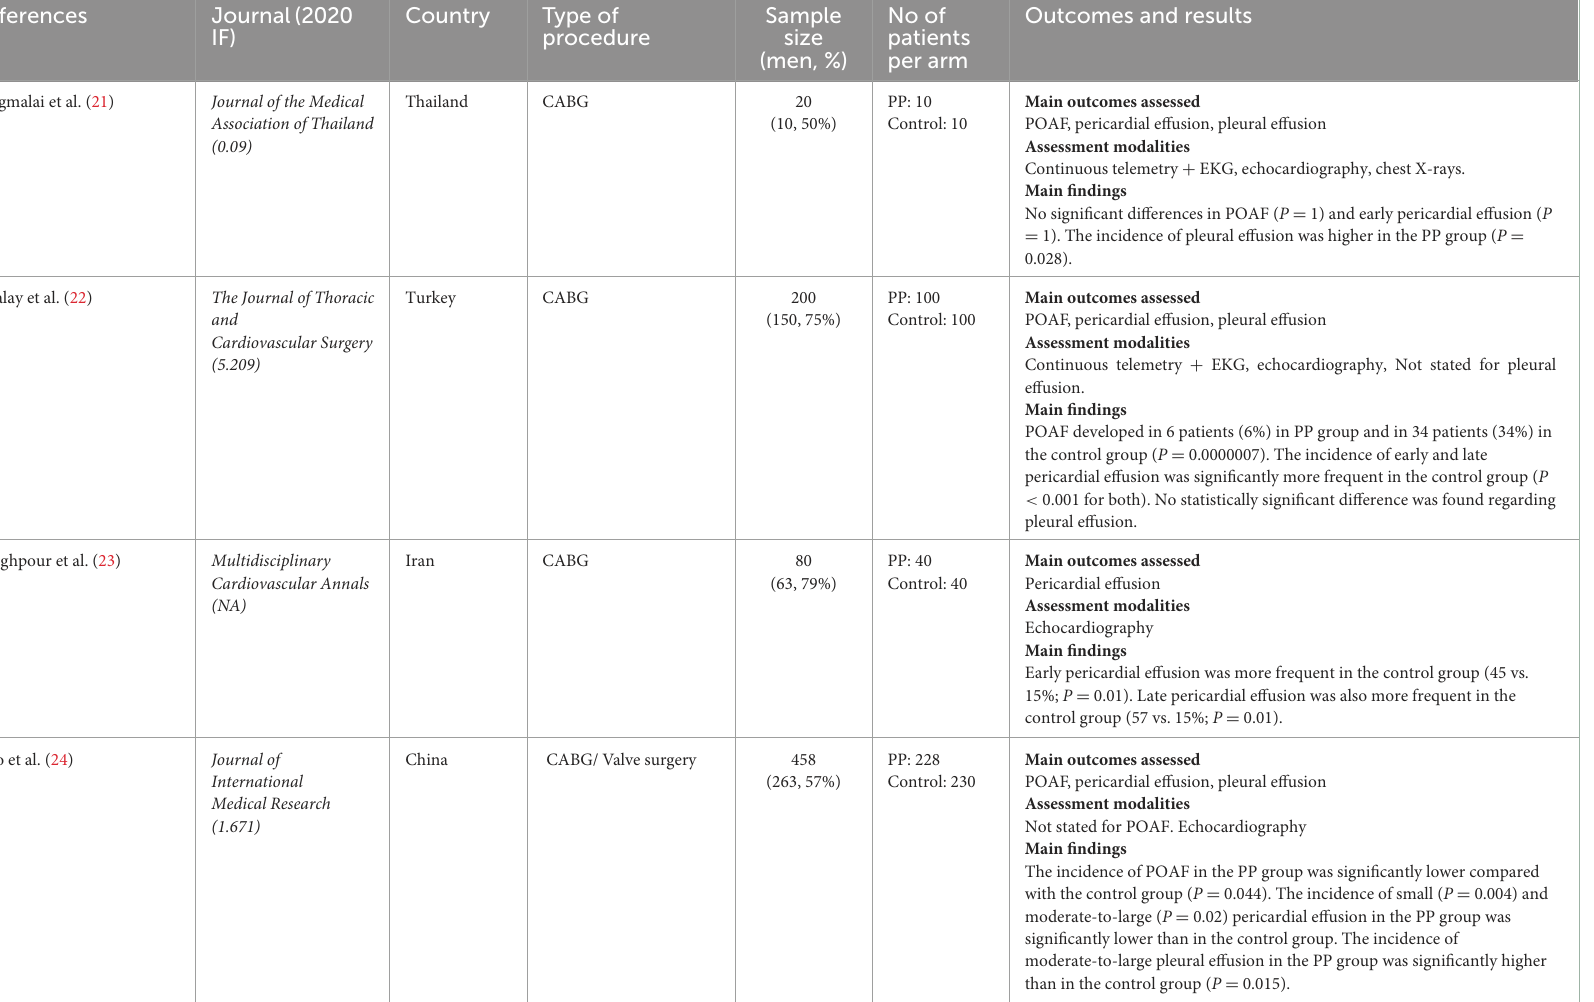
Main outcomes assessed POAF, pericardial effusion, pleural effusion Assessmentmodalities Continuous telemetry + EKG, echocardiography, chest X-rays. Main findings No significant differences in POAF ( P = 1) and early pericardial effusion ( P = 1). The incidence of pleural effusion was higher in the PP group ( P = 0.028). Main outcomes assessed POAF, pericardial effusion, pleural effusion Assessmentmodalities Continuous telemetry + EKG, echocardiography, Not stated for pleural effusion. Main findings POAF developed in 6 patients (6%) in PP group and in 34 patients (34%) in